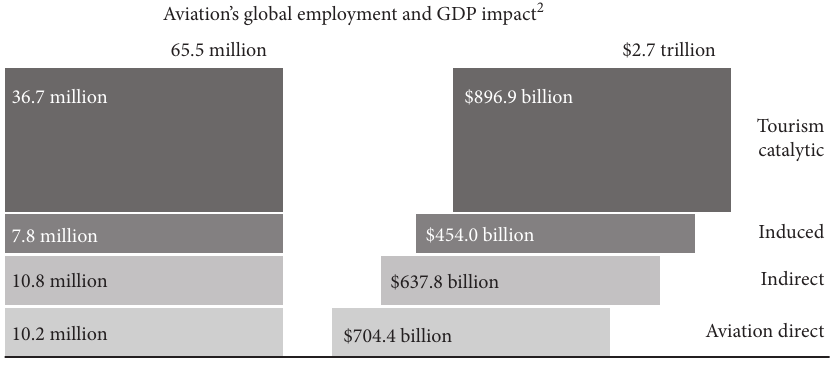
Figure 1: Aviation global employment and GDP impact (2019)